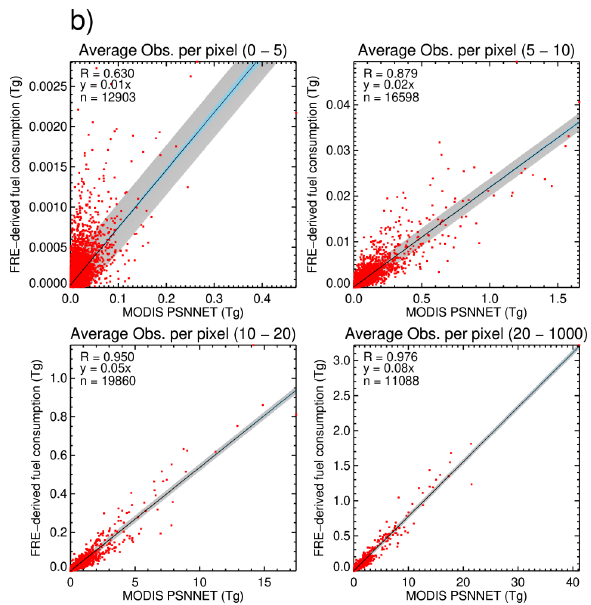
Figure 5. The relationship between FRE-derived fuel consumption (Tg DM) and accumulated MODIS PSN (Tg) on a per-fire cluster basis in the northern ( a ) and southern ( b ) hemisphere Africa as a function of the average number of SEVIRI fire detections per pixel within each fire cluster. The grey shaded area represents the prediction interval and the blue shaded area is the slopes 95% confidence interval. Note that the x - and y -axis range differs among plots.